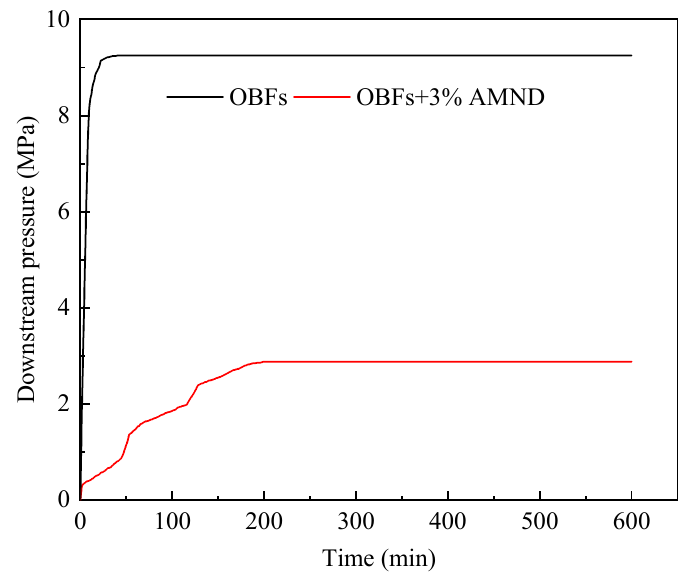
Figure 11. Experimental results of the pressure transfer test.